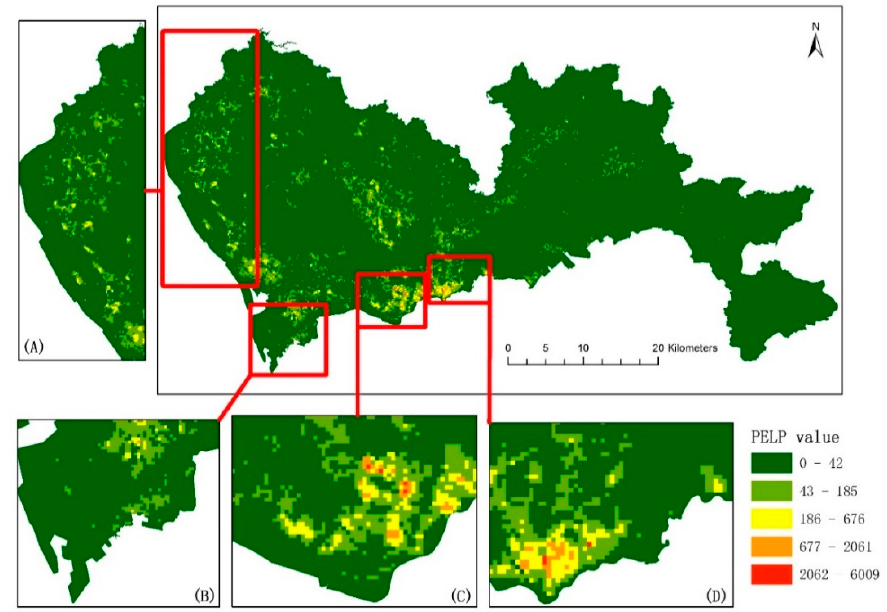
Figure 3. Spatial distribution of population exposure to light pollution (PELP) in Shenzhen. ( A ) Bao’an District, ( B ) Nanshan District, ( C ) Futian District, ( D ) Luohu District.